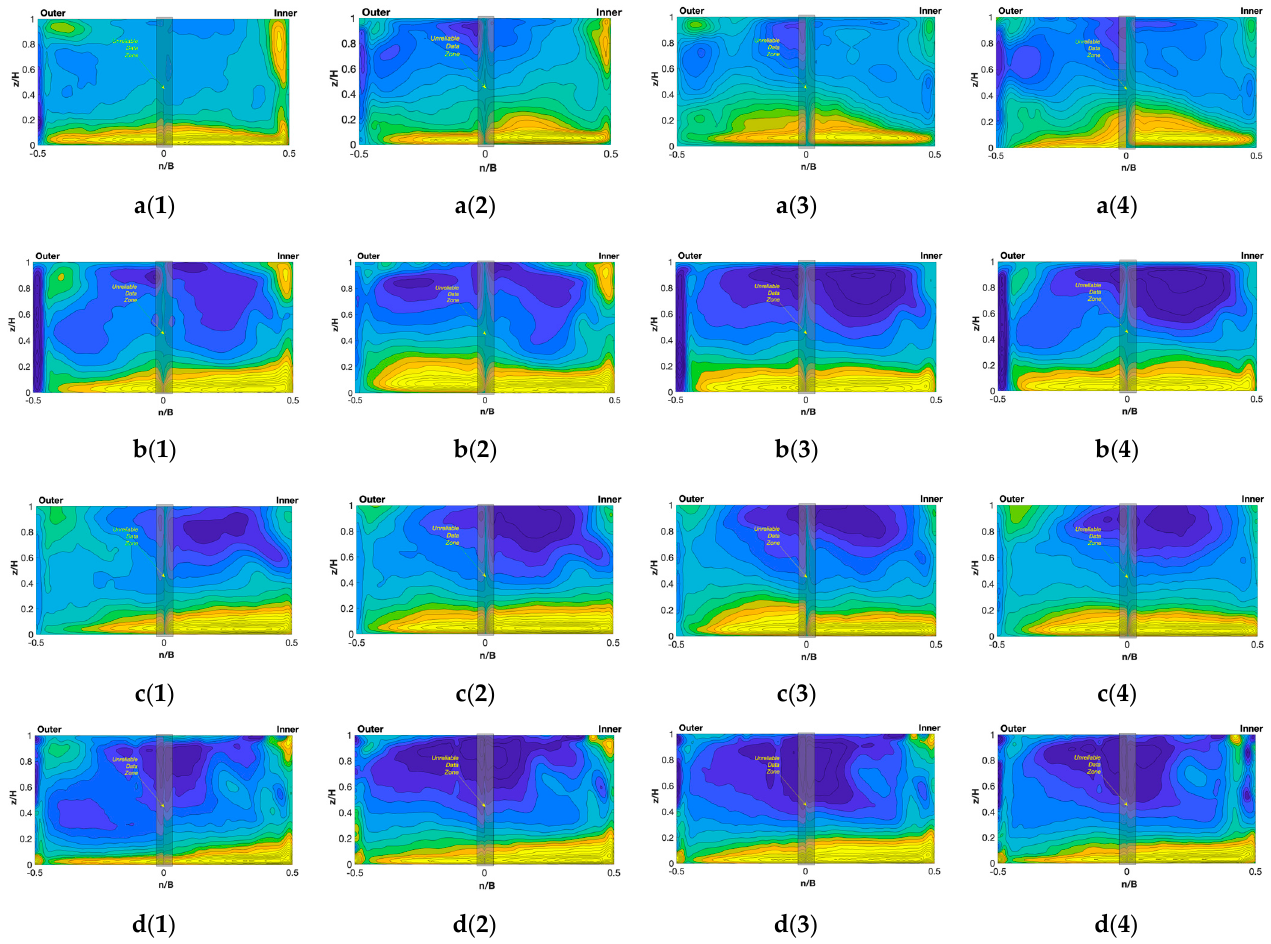
Figure 7. Dimensionless transverse velocity distribution at ( a ) 37 degrees; ( b ) 90 degrees; ( c ) 105 degrees; ( d ) 125 degrees. The numbers 1, 2, 3, and 4 denote different jet conditions (1) no jet; (2) S = 3.5; (3) S = 10; (4) S = 16.5.